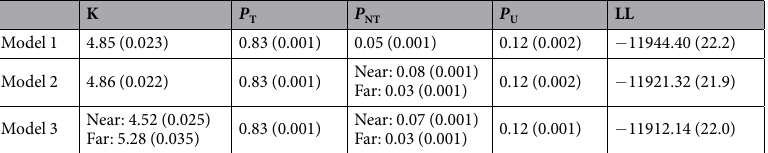
Table 2. Estimates from the mixture models for Experiments 1 calculated using a model in which neither K nor P NT could differ between Near and Far conditions (Model 1), a model in which only P NT could differ (Model 2) and a model in which both K and P NT could differ (Model 3). The 95% confidence interval is shown in parentheses, which was found by bootstrapping the data 100 times. LL denotes the log